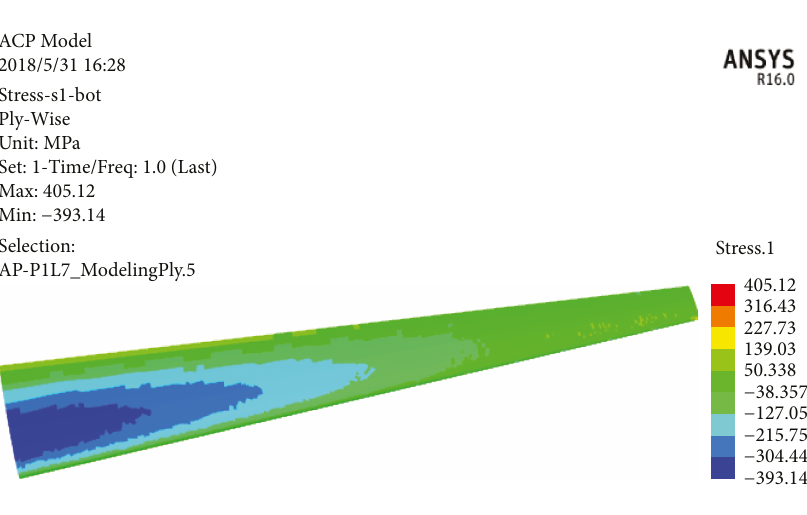
Figure 48: Stress cloud diagram of the upper wing with the layer ratio being 30%/60%/10%.